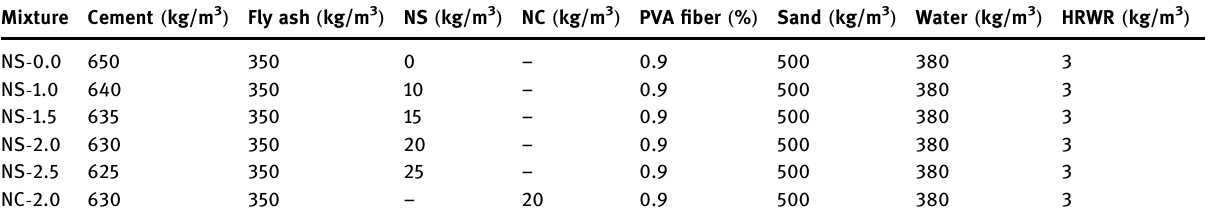
Table 5: Mix proportions for